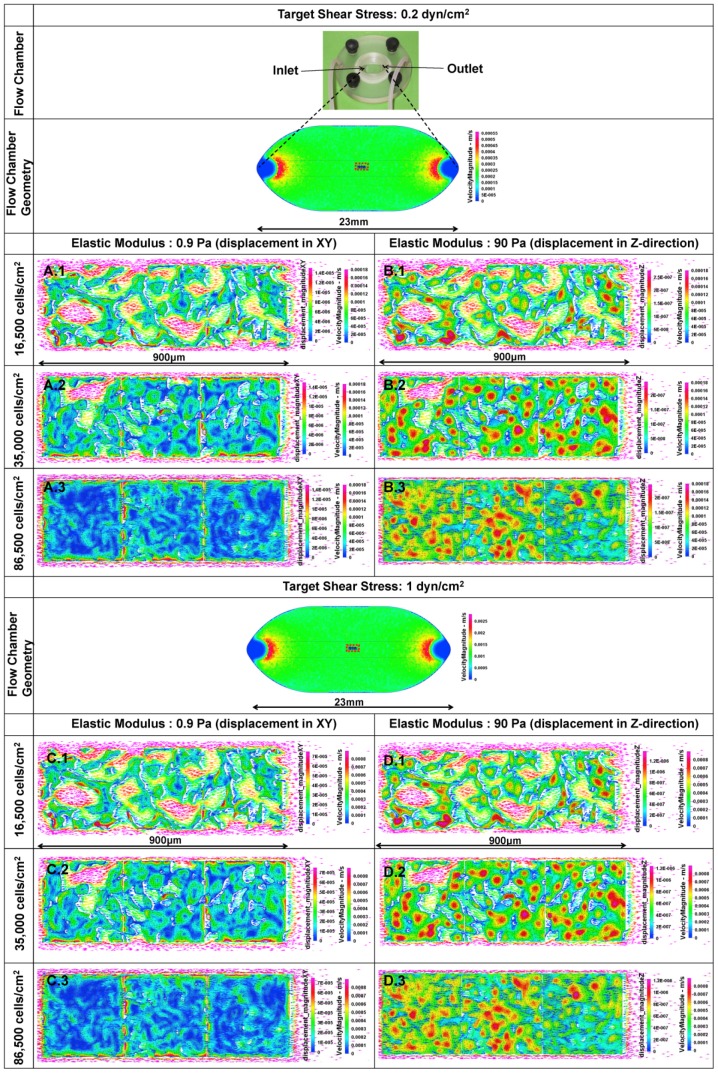
Experimental and computational analysis of flow regimes around live stem cells.(A) 2D micrographs of μ-PIV experiments show flow regimes in the apical and basal regions of the live stem cell (target shear stress imparted by flow: 0.2 dyn/cm2). (B,C) Validated computational fluid dynamics (CFD) predictions of velocity gradients (which drive shear gradients and hence target shear stresses) in the apical and basal regions of cells, at flow rates including 0.2 and 1 dyn/cm2, respectively. * indicates statistical significance, defined by p<0.05. Error bars show standard errors (n = 3).